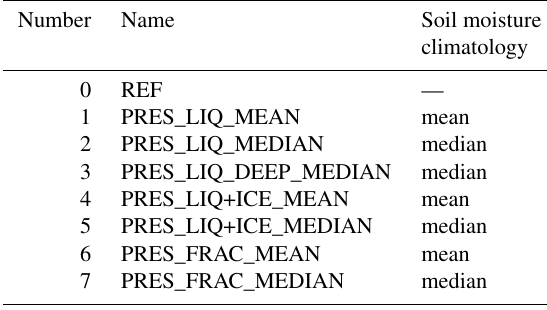
Table 1. Names of simulations used in the study. Number Soil moisture